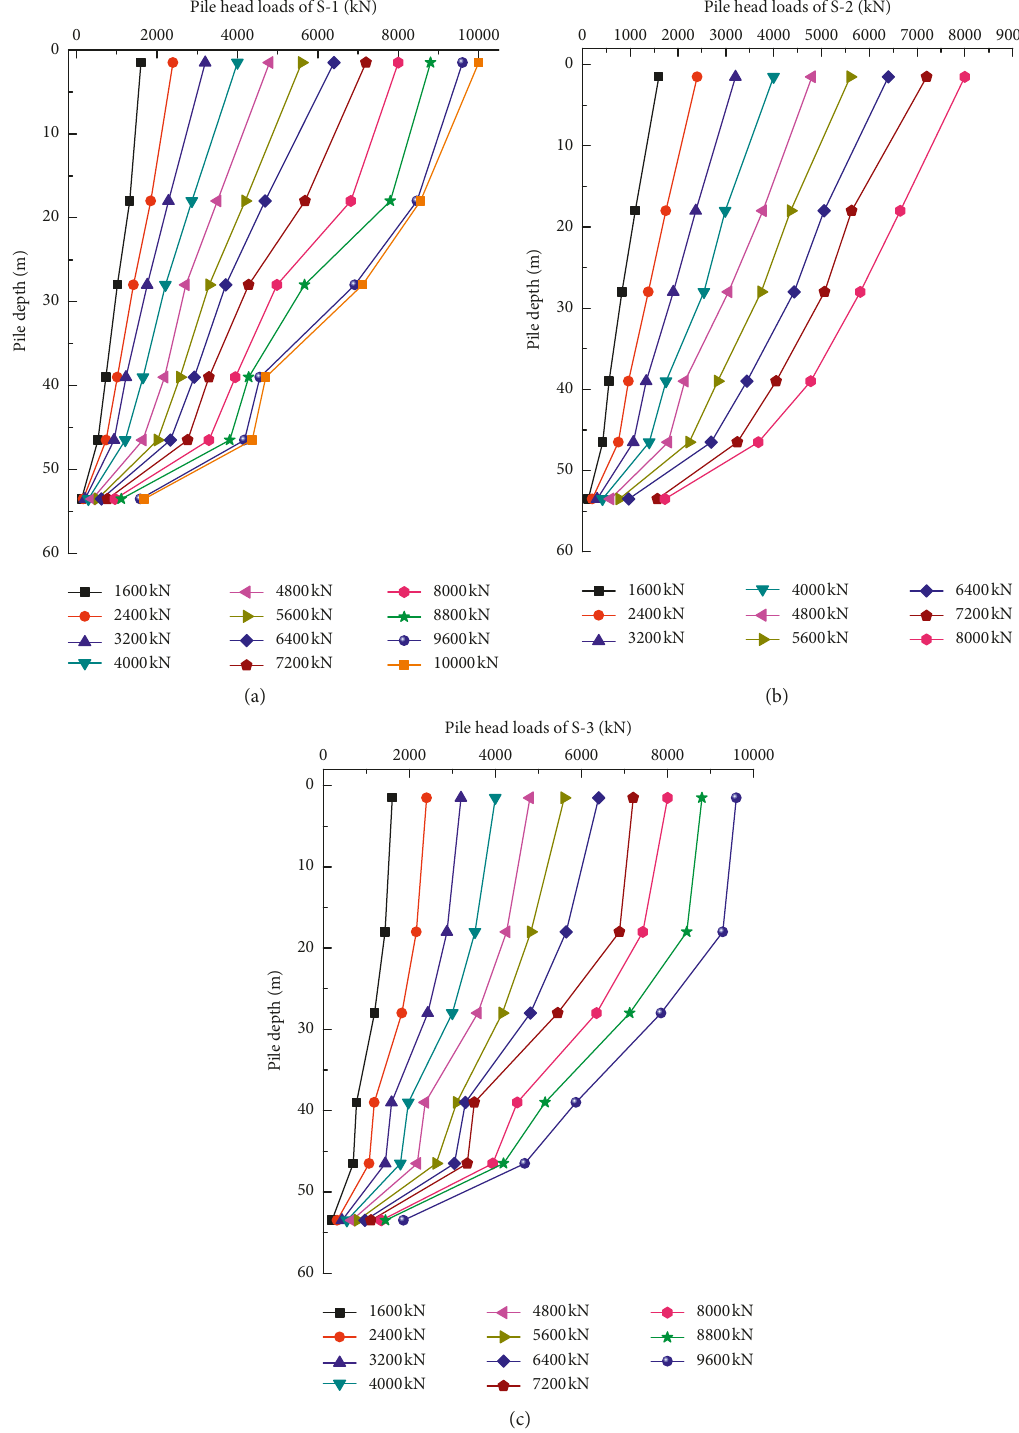
Figure 5: Distributions of axial pile